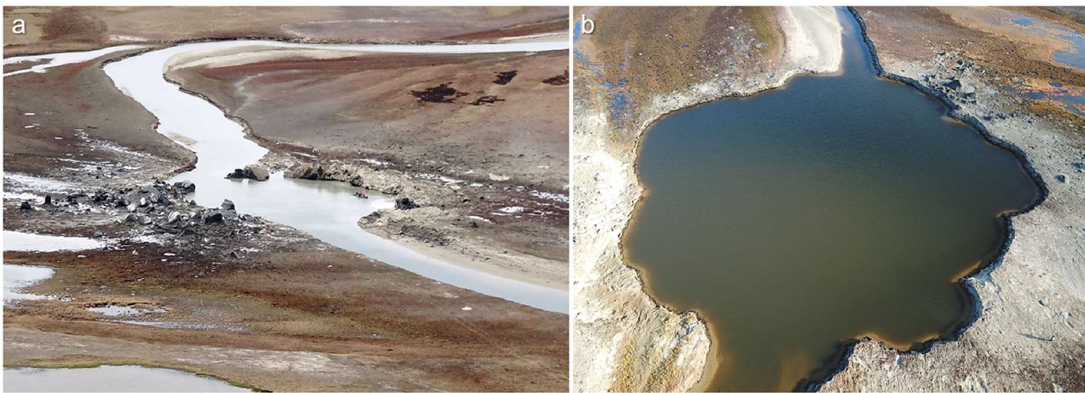
Figure 2. Seyakha gas blowout crater. Photos from a helicopter, 2 July 2017 ( a ) and a drone, 19 September 2018 ( b ). Source: Vasily and Igor Bogoyavlensky. Investigation of the crater lake bottom was carried out from two inflatable “Lotsman”